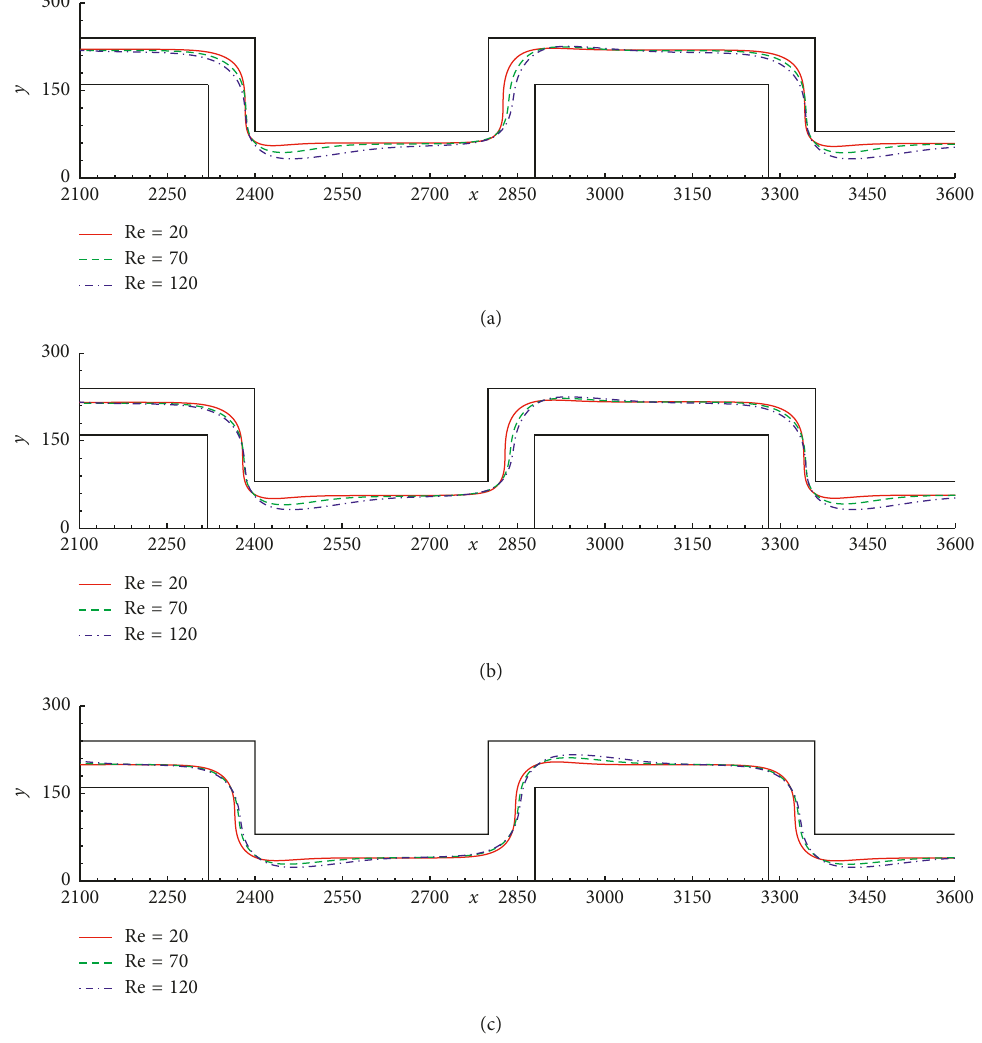
Figure 4: Particle trajectories at Re